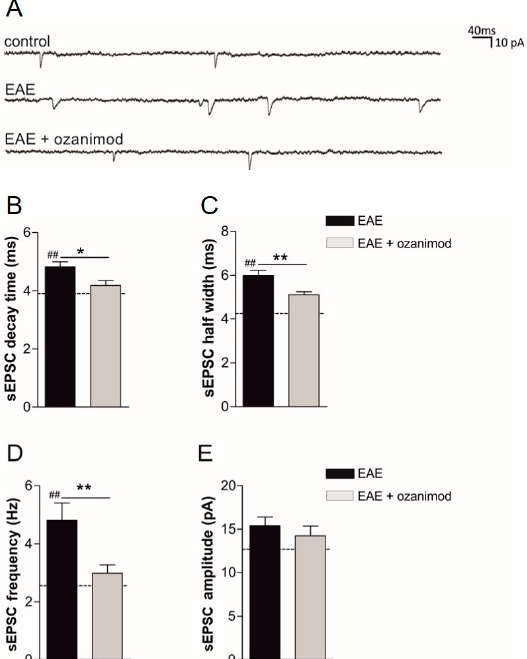
Figure 1. Ex vivo treatment of corticostriatal slices with ozanimod recovers synaptic alterations induced by experimental autoimmune encephalomyelitis (EAE). ( A ) Examples of spontaneous glutamate-mediated excitatorypostsynapticcurrents(sEPSC)tracesrecordedfrommediumspinyneurons(MSNs)incorticostriatal slices in the different experimental conditions (healthy control, EAE, EAE + ozanimod). Bath incubation corticostriatal slices with ozanimod (1000 nM, 2 h) recovers EAE-induced alterations of glutamatergic transmission, in terms of decay time ( B ), half width ( C ), and frequency ( D ). sEPSC amplitude is not affected by ozanimod treatment ( E ). Dotted lines refer to healthy mouse values. Data are expressed as mean ± SEM. Unpaired t -test, * p < 0.05; ** p < 0.01 EAE vs. EAE + ozanimod; ## p < 0.01 EAE vs. healthy